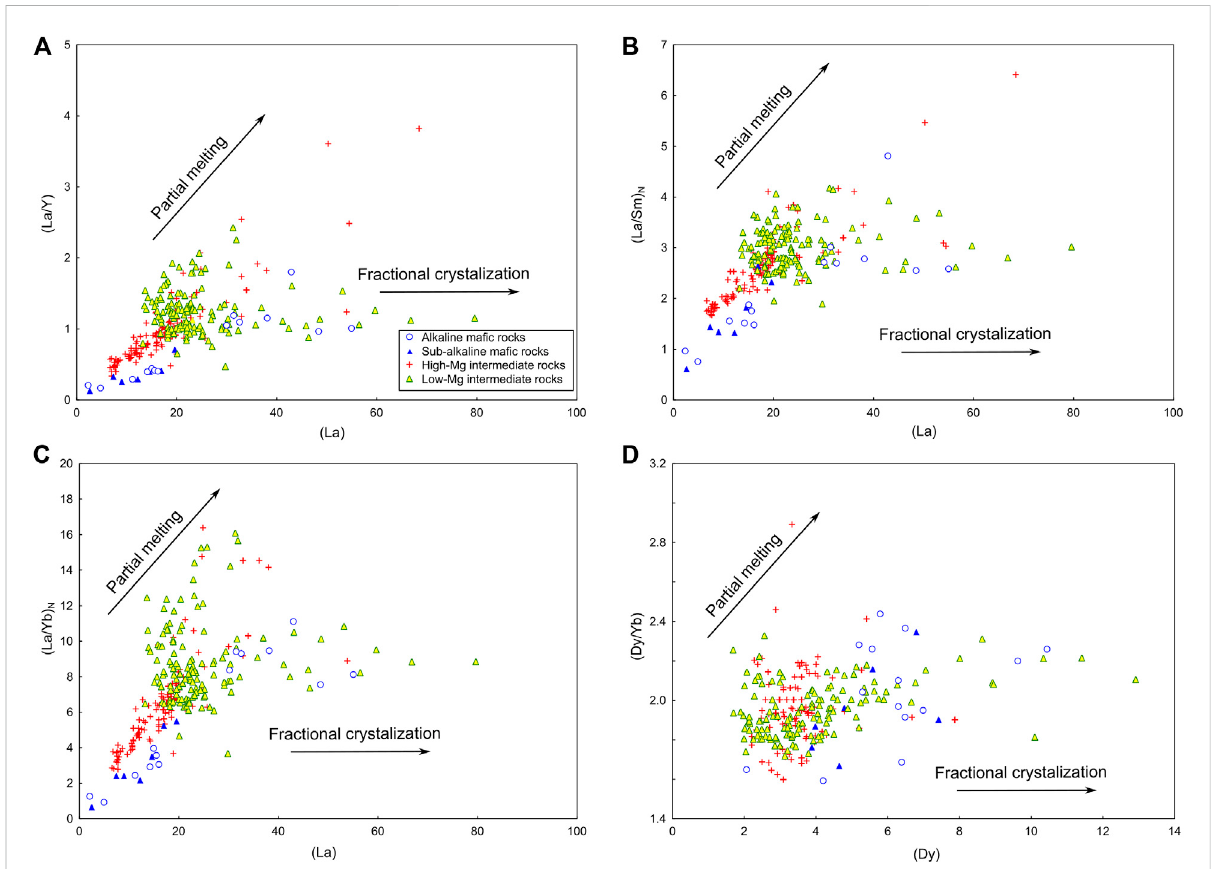
FIGURE 7 (A – D) Immobile trace element ratio diagram illustrating the partial melting and fractionation effects in the MGVF volcanic